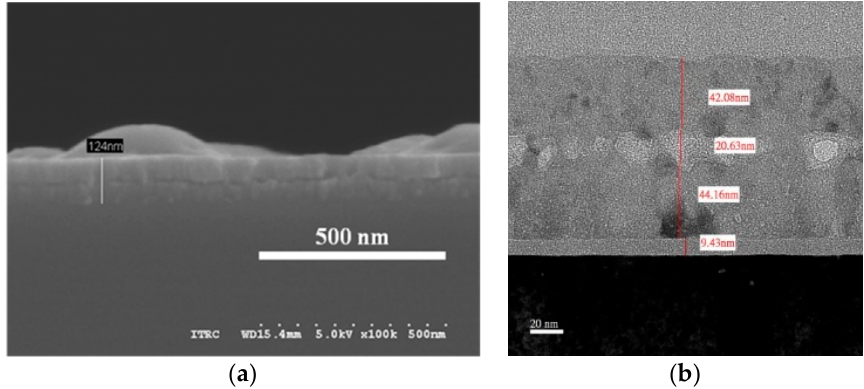
Figure 2. Cross-sectional images of Al 2 O 3 /MgO/Al 2 O 3 thin films after a 4-h annealing process at 800 °C: ( a ) SEM; and ( b ) TEM.